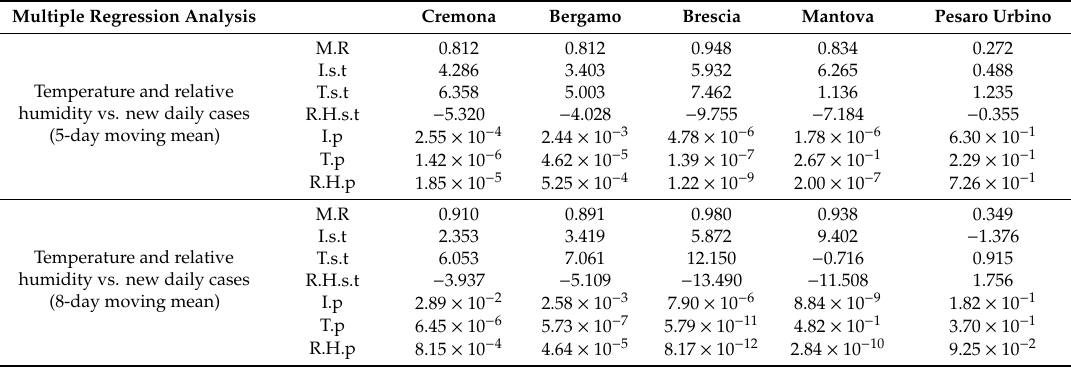
Multiple Regression